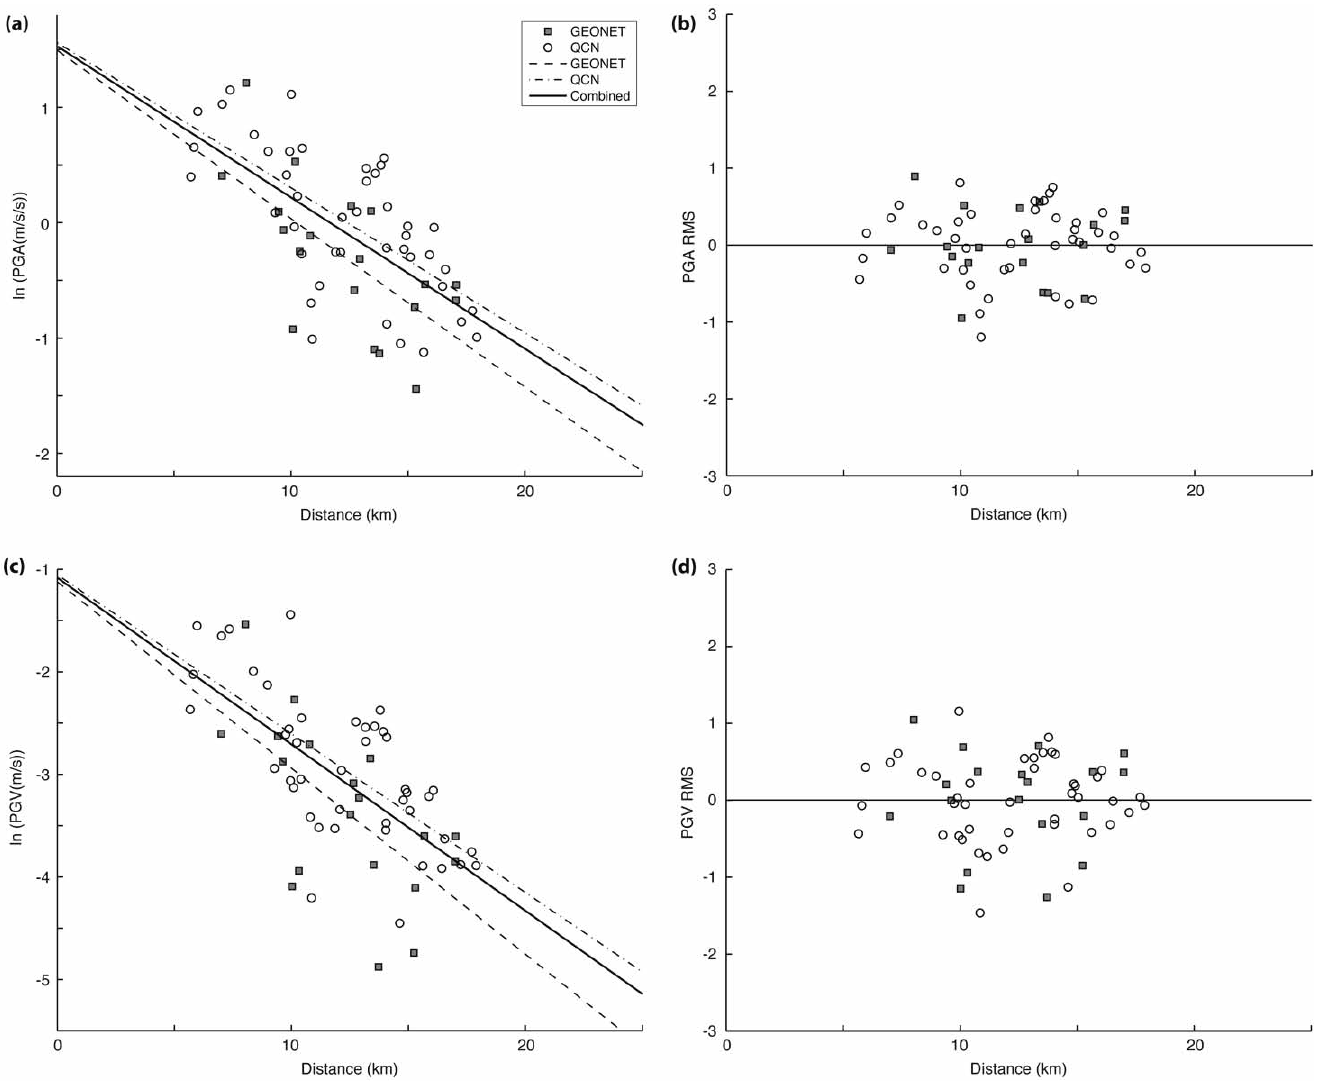
versus distance observed on QCN (circles) and GeoNet (squares) for the October 18, 2010, M5.1 aftershock. Dashed line shows the Figure 3. (a) PGA H linear least-squares fit to all of the data. (b) Detrended PGA (circles) and GeoNet (squares) for the same event shown in (a) (d) Detrended PGV given in Table 2.